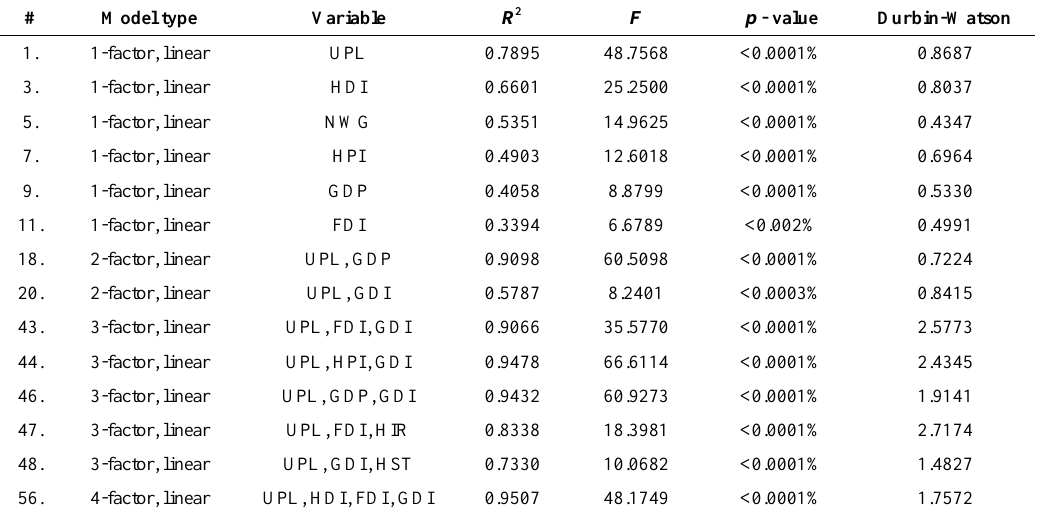
Table 3. Final regression models